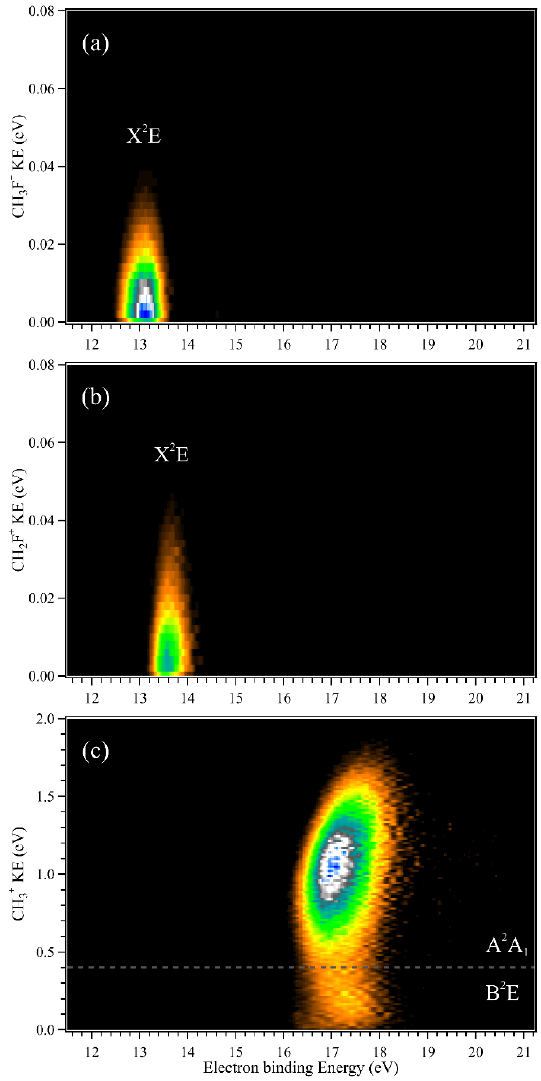
Figure 8. Electron and ion kinetic energy correlation diagrams corresponding to ( a ) the CH 3 F + parent ion, ( b ) the CH 2 F + fragment ion, and ( c ) the CH 3+ fragment ion . Panel ( c ) is adapted with permission ion, ( b ) the CH 2 F + fragment ion, and ( c ) the CH 3 + fragment ion. Panel ( c ) is adapted with permission from Ref. [43]. Copyright 2017 American Chemical Society. from Ref. [43]. Copyright 2017 American Chemical